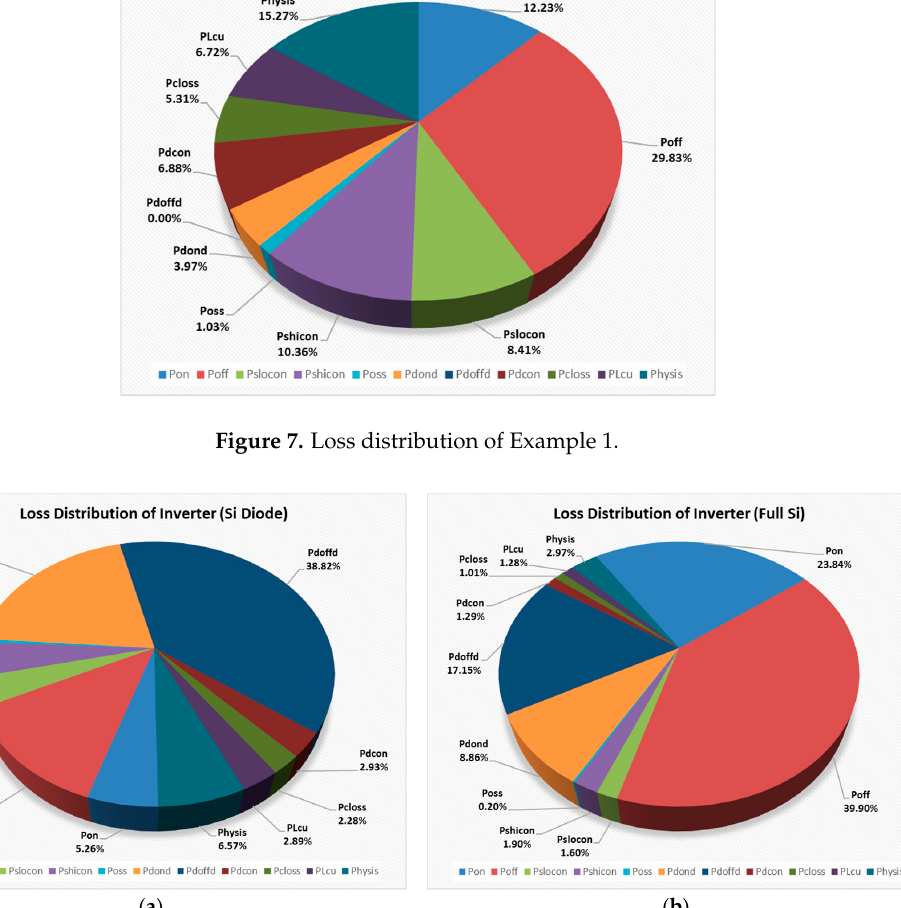
Figure 8. Loss distributions of the comparative calculation examples: ( a ) Example 2; and ( b ) Example 3.